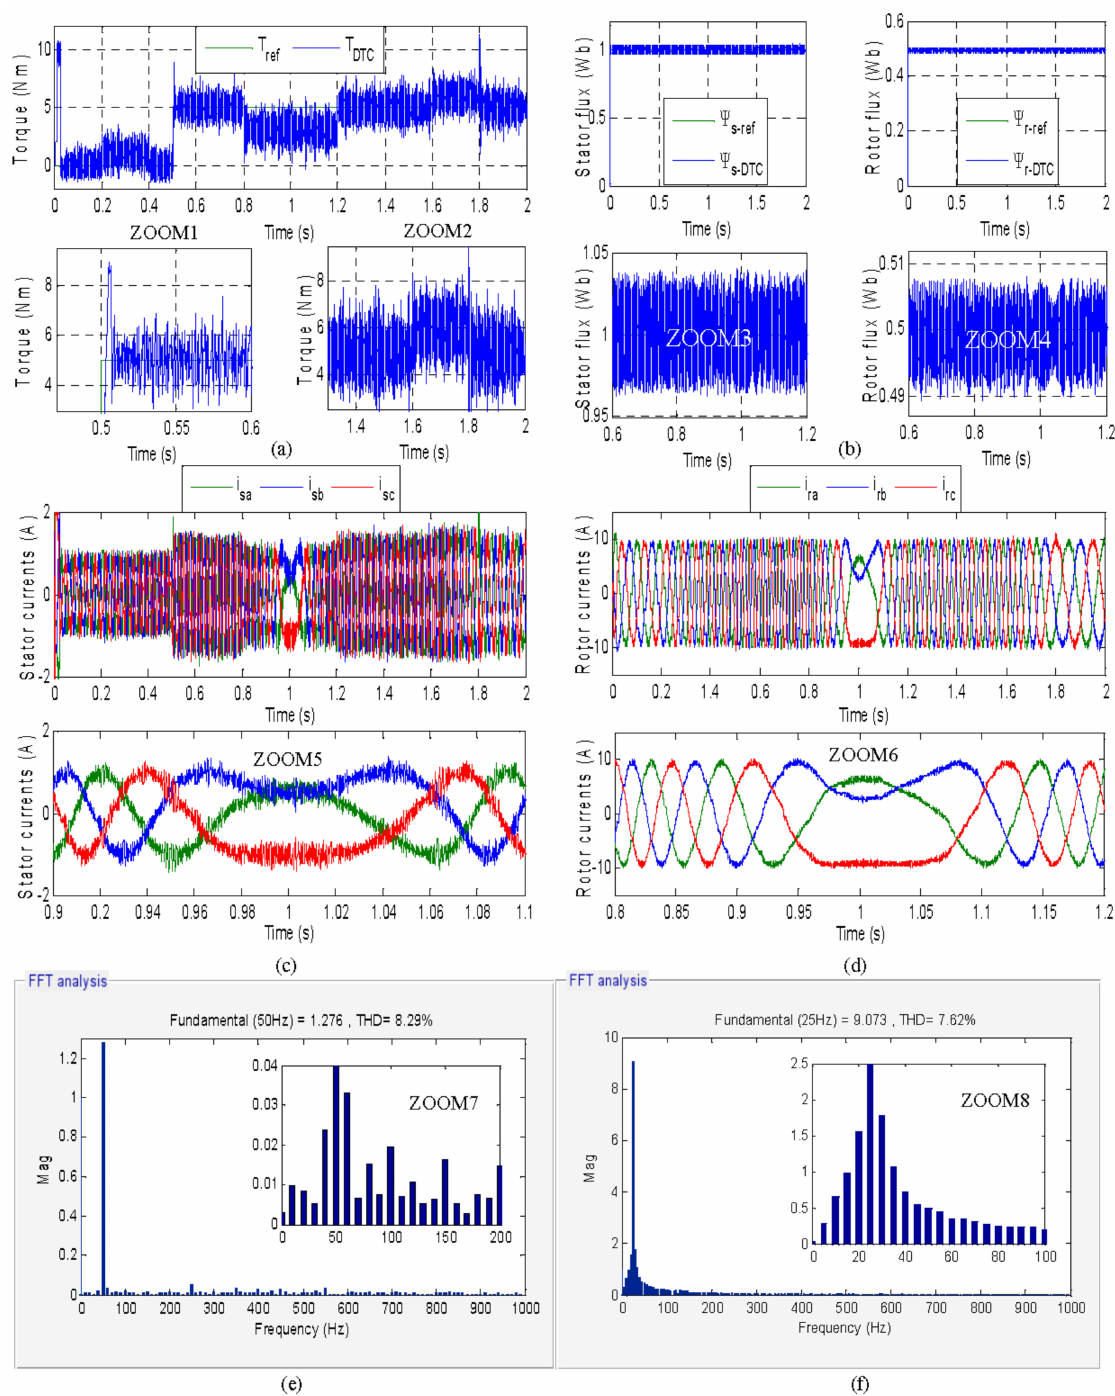
Figure 6. DTC performances. ( a ) The electromagnetic torque response. ( b ) The fluxes response. ( c , d ) The stator and rotor currents. ( e , f ) Harmonic spectra of the stator and rotor